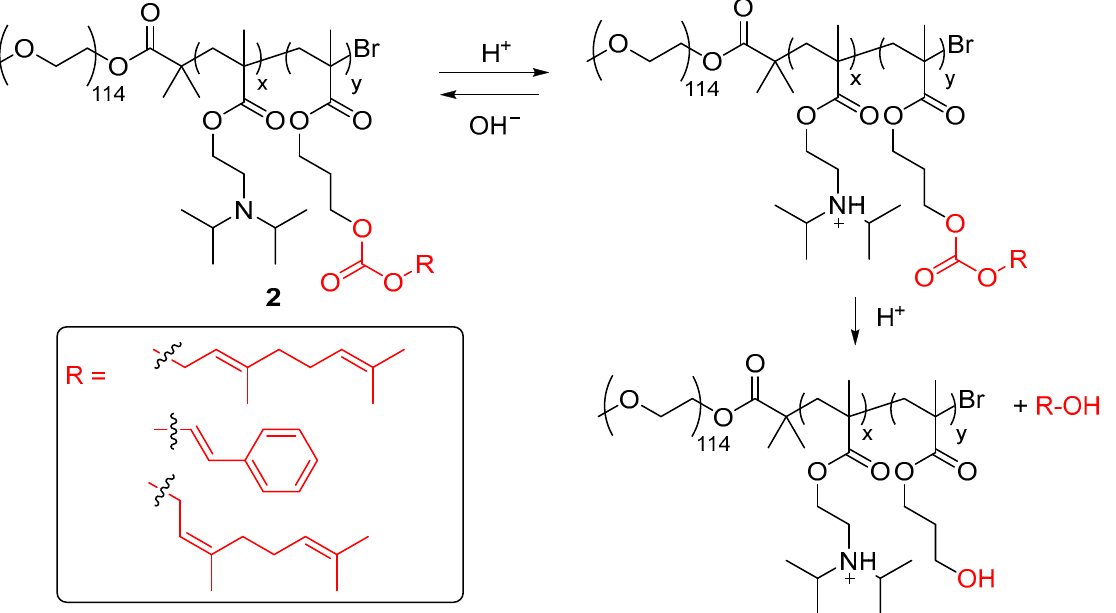
Figure 2. Chemical transformation of the polymeric profragrances 2 by the application of acid/base stimuli. The precursor of alcohol fragrances is highlighted. The different substituents of the alcohol fragrances tested by the authors are included in a box. The original results were reported by Zhu and coworkers [28].